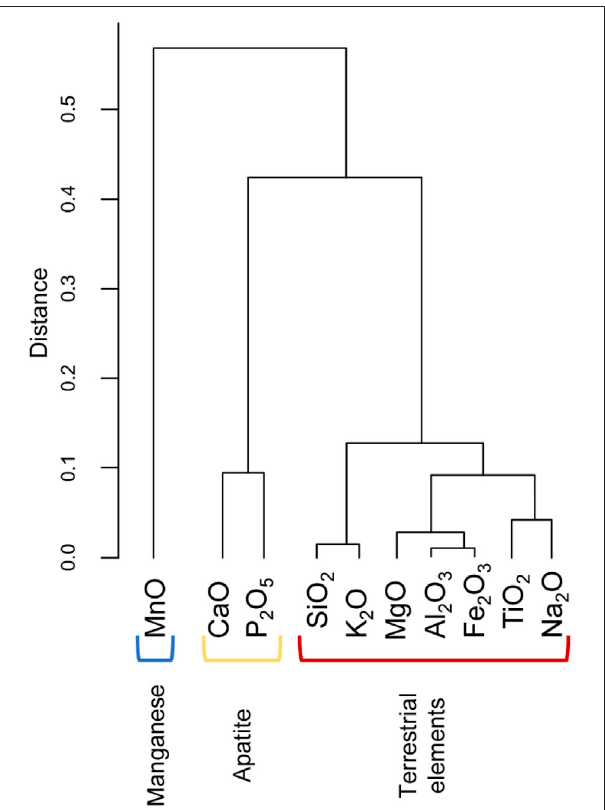
FIGURE 7 | Cluster analysis of the major element composition of intercalated mudstones in Section R and Section Q. Variation matrix (Aitchison, 1986) and Ward method was used for the distance. Three components that control the bulk chemical composition of the intercalated mudstone are classi fi ed ( “ manganese ” ; “ apatite ” ; “ terrestrial elements ” ).